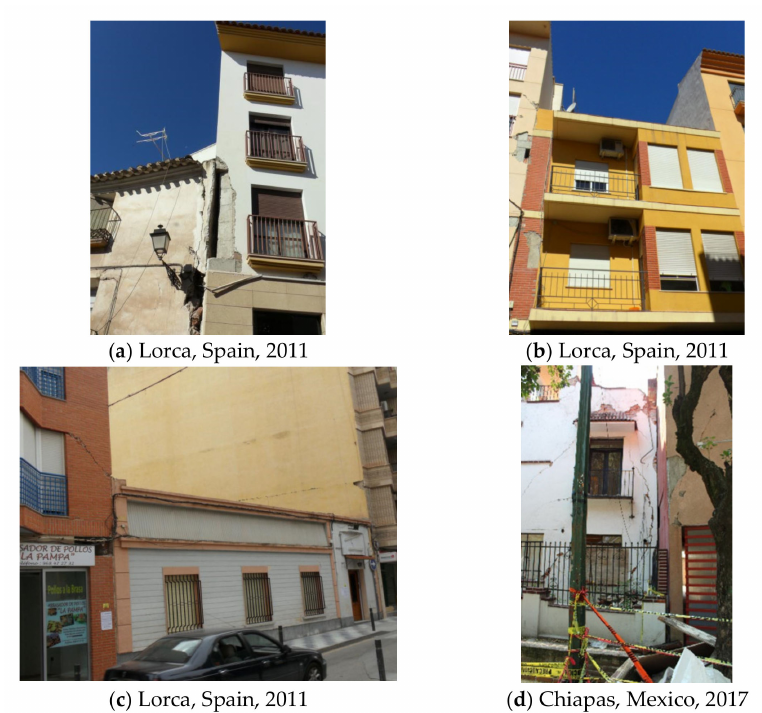
Figure 16. Damage type 8—example of pounding effect after the Lorca, Spain 2011 earthquake: ( a ) adjacent buildings with different heights; ( b – d ) cumulative stresses and cracking in common points among adjacent